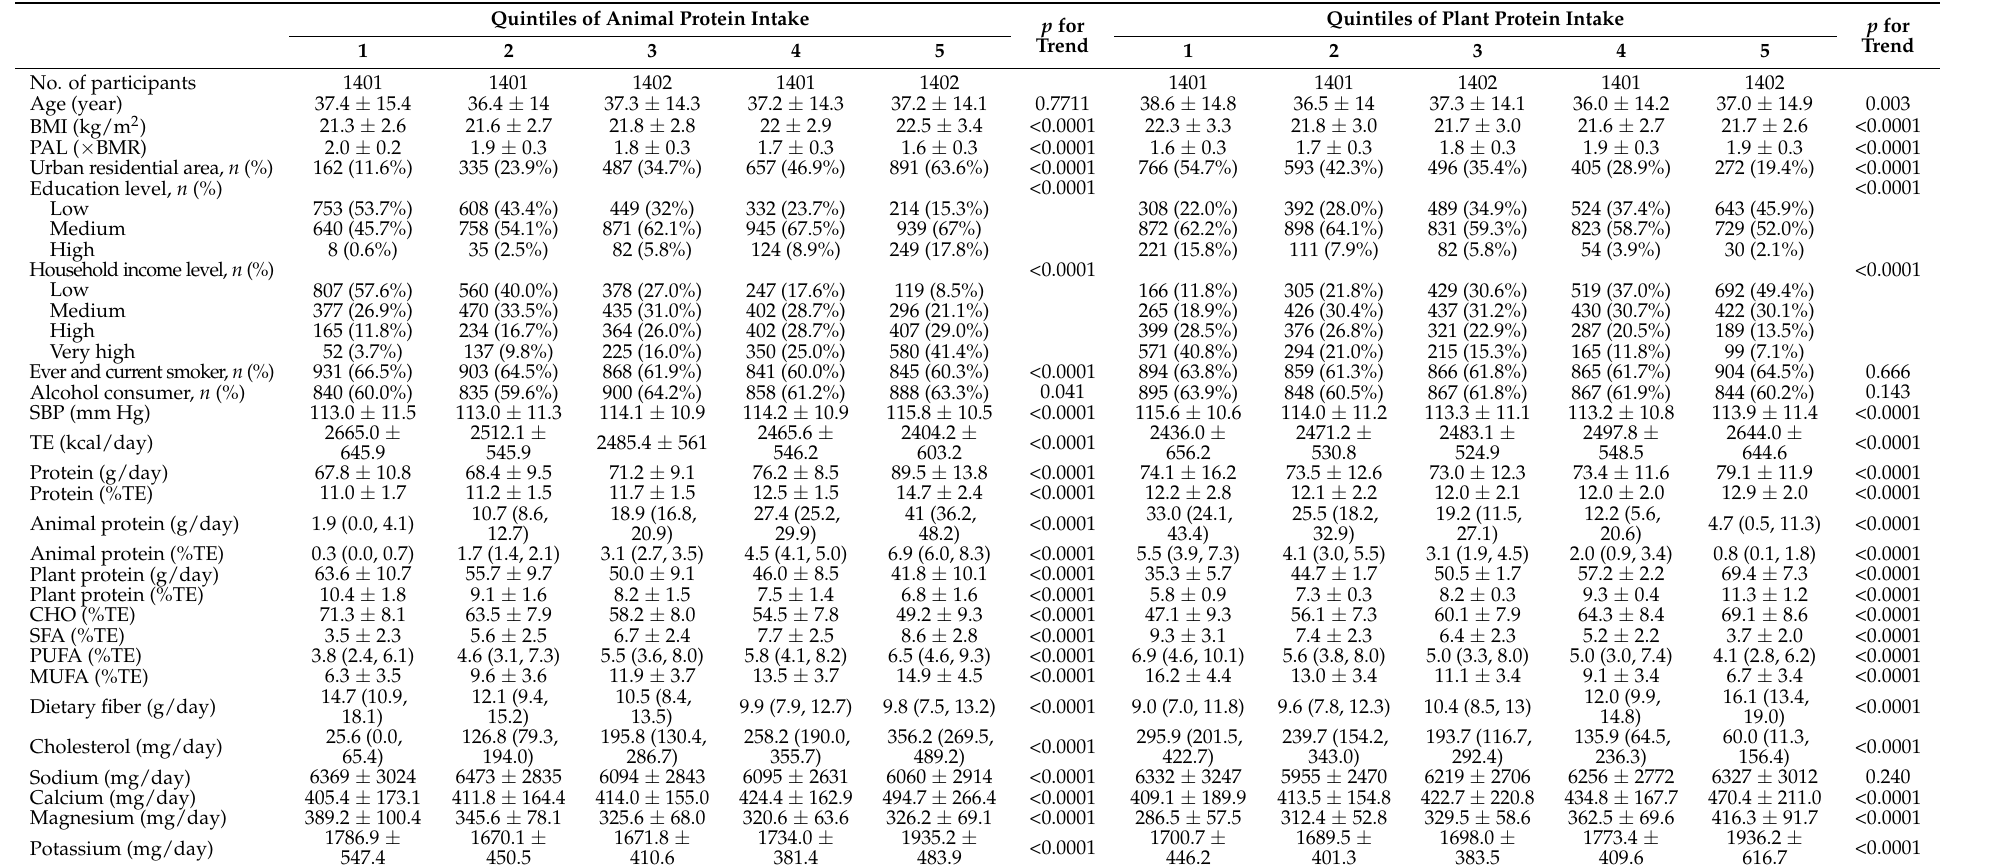
Table 1. Baseline sociodemographic and lifestyle factors and cumulative average dietary intakes in 7007 men according to quintiles of animal and plant protein intake 1